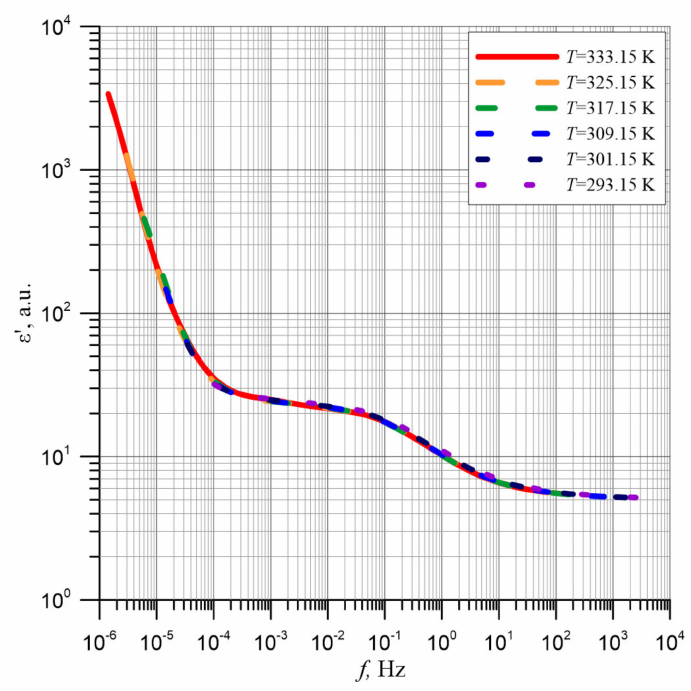
Figure 8. Permittivity relationships ε (cid:48) for different measurement temperatures converted to a refer- ence temperature of 293.15 K by means of the average activation energy of the relaxation time